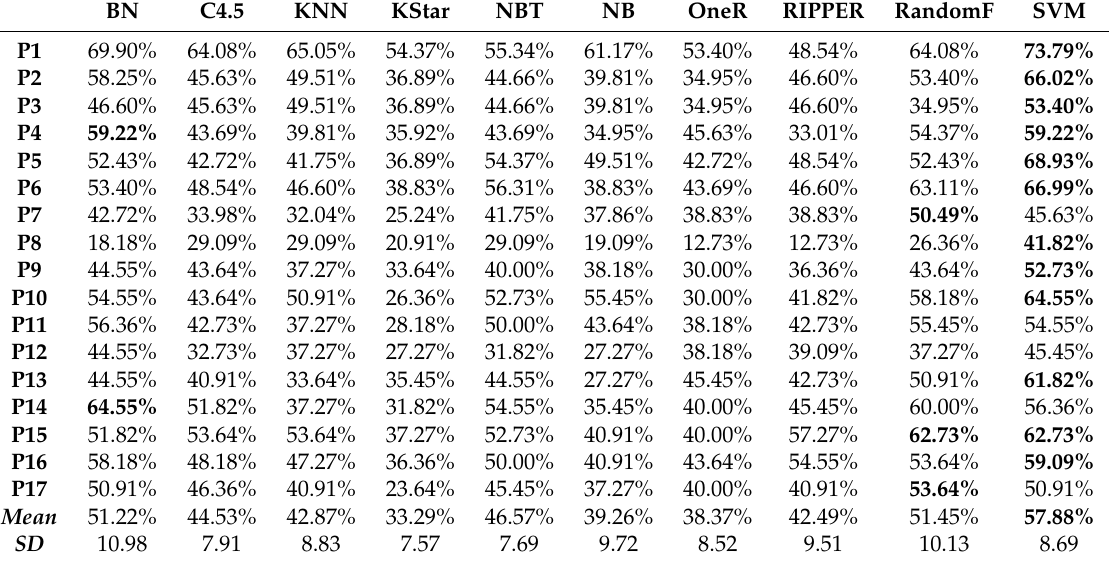
Table 2. First phase. Accuracy percentages for each person using single classifiers. Mean and SD rows denote the average and standard deviation for each classifier considering all of the actors. BN, Bayesian network; NBT, naive Bayes tree; OneR, one rule; RIPPER, repeated incremental pruning to produce error reduction; RandomF, random